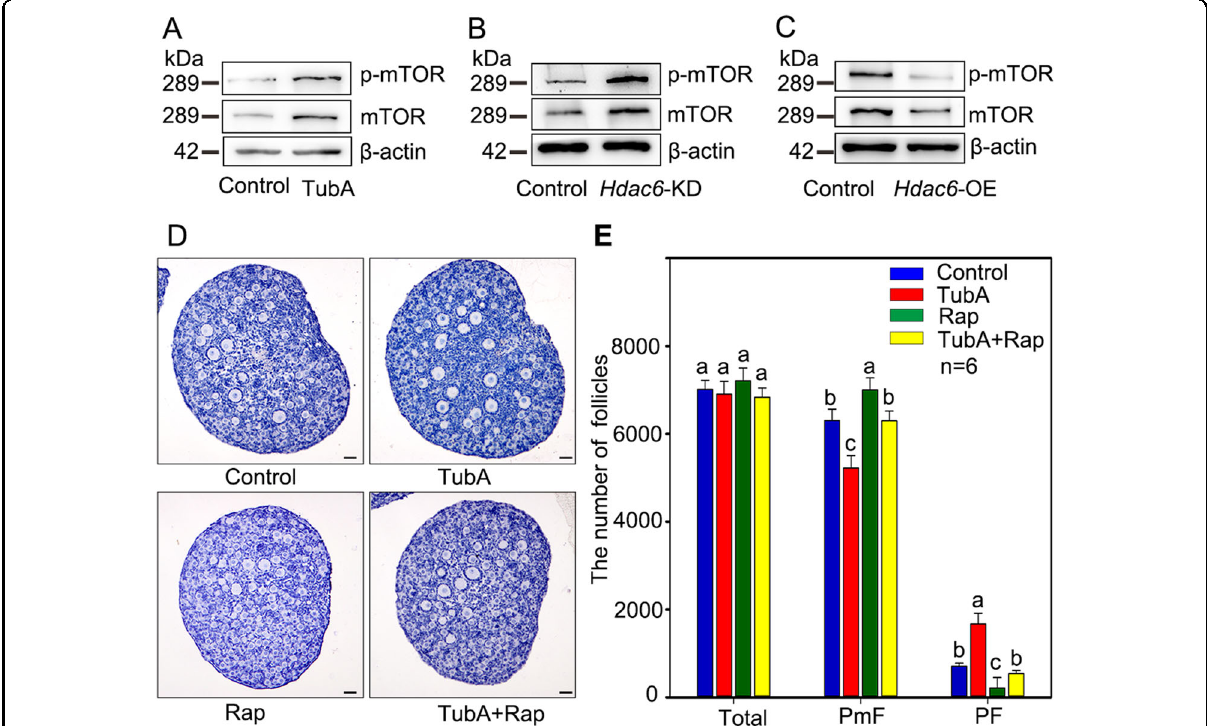
Fig. 3 HDAC6 is responsible for primordial follicle activation by regulating mTOR signaling pathway. A – C The mTOR signaling pathway in the ovaries was affected by either inhibiting or elevating the level of HDAC6. Western blotting results showed that both total-mTOR and p-mTOR were increased in the TubA group or Hdac6 -KD group compared with those in the respective controls. On contrary, Hdac6 -OE treatment decreased the levels of both total-mTOR and p-mTOR compared with the control. D , E The histological analysis and counting results showed that the primordial follicle activation was reversed in TubA plus Rap treatment compared with TubA treatment alone. The experiments were repeated at least three times. And representative images are shown. The data are presented as the means ± SEM. Scale bars: 50 μ